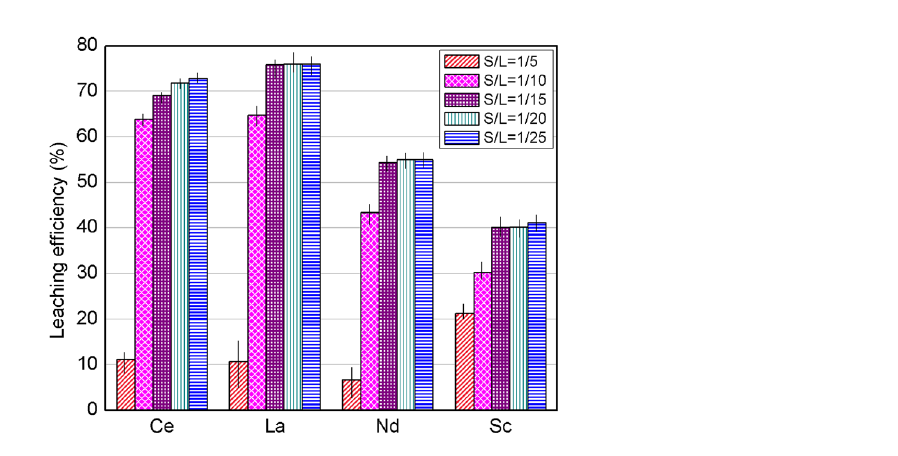
Figure 3. Effect of solid to liquid ratio (S/L) on the leaching efficiency of cerium (Ce), lanthanum (La), neodymium (Nd), and scandium (Sc) using 1.5 M H 2 SO 4 at 90 °C within 30 min residence time. Error bars represent the standard error of the mean for four